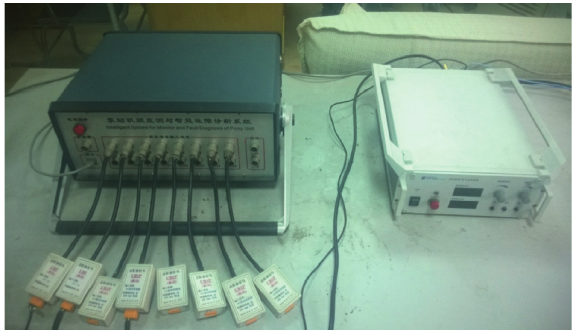
Figure 5: Signal collection and experimental control device.